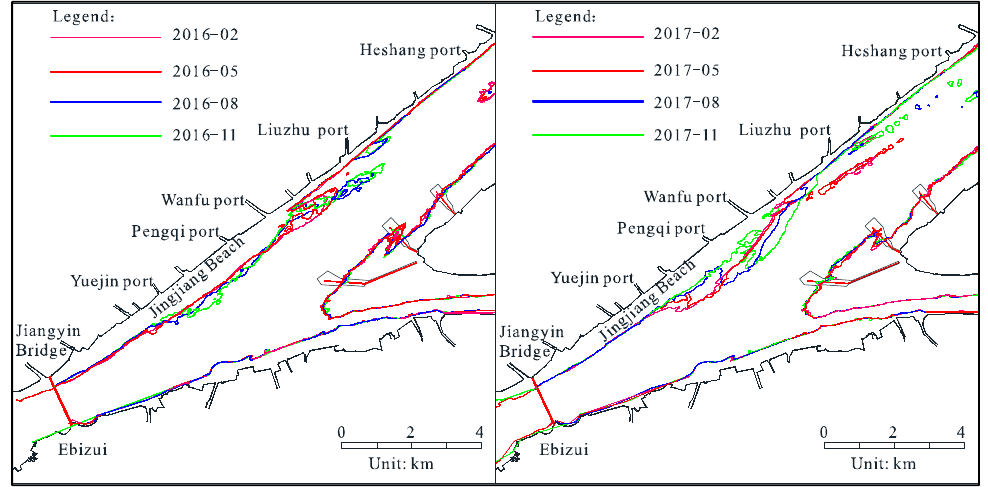
Figure 6. Evolution of the 10 m isobath of Jingjiang Beach under the effect of the second stage of the DCP from 2016 to 2017.